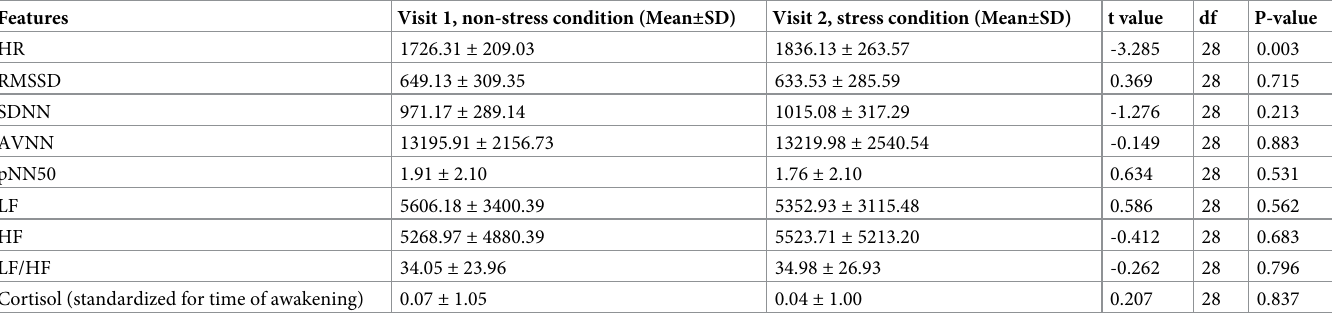
Table 2. Within-subject comparison of AUC values for HR, HRV parameters, and cortisol between stress and non-stress conditions.